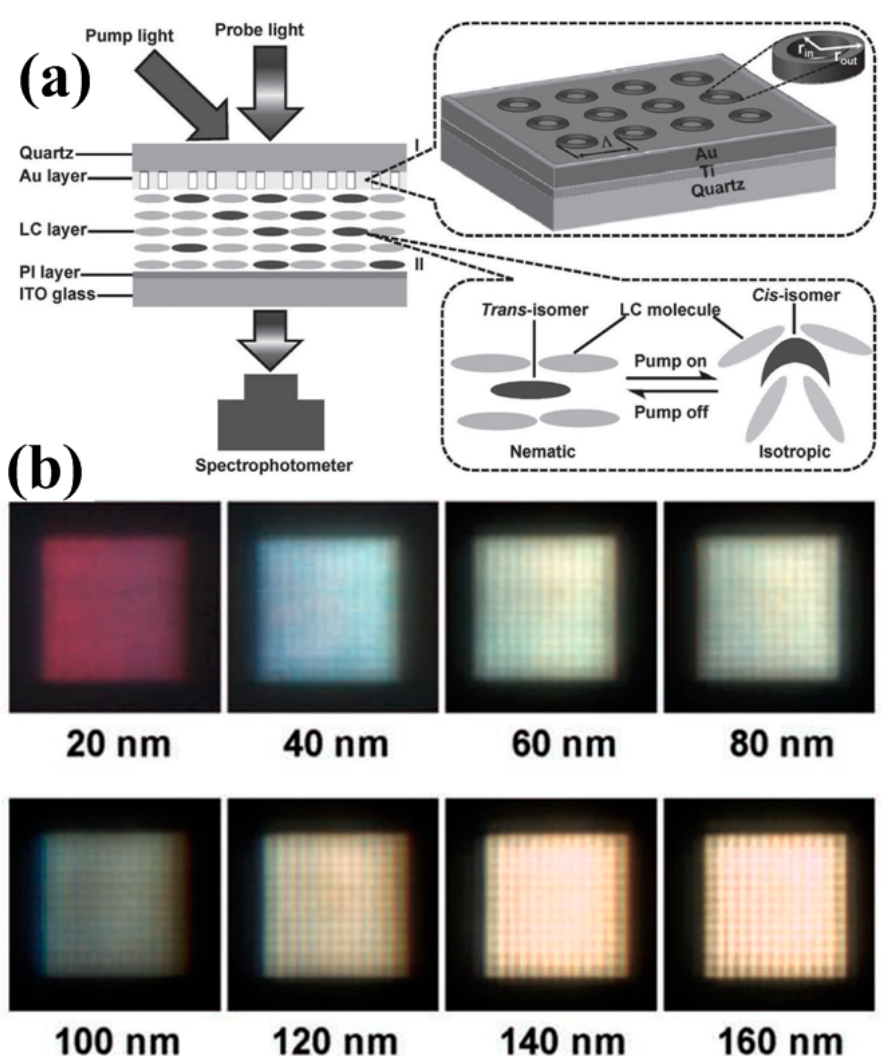
Figure 9. ( a ) Schematic of the tunable coaxial color filter structure and experimental setup using liquid crystals (LCs); ( b ) charge-coupled device (CCD) captured colors with varying aperture sizes showing different outputs. All figures are adapted from reference [89].